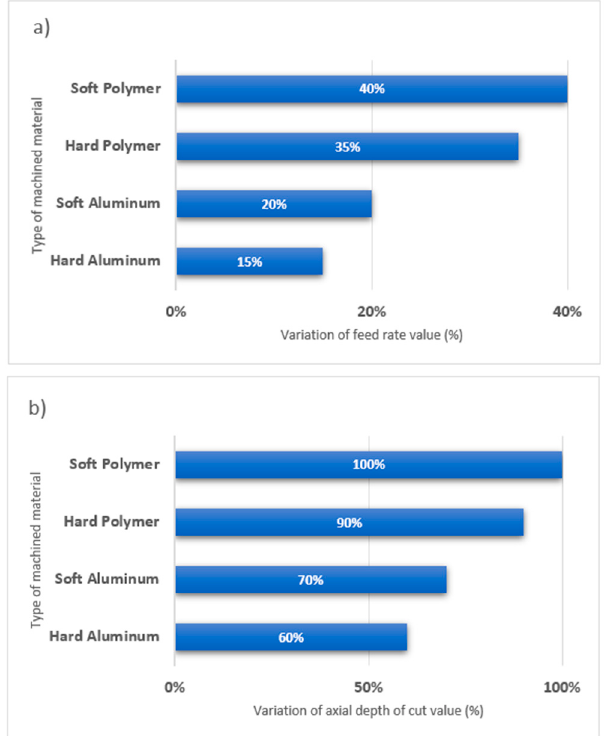
Figure 4. Variation of feed rate ( a ); and axial depth of cut ( b ) value, percentual, for the machining of soft and hard aluminum alloys and polymeric materials.